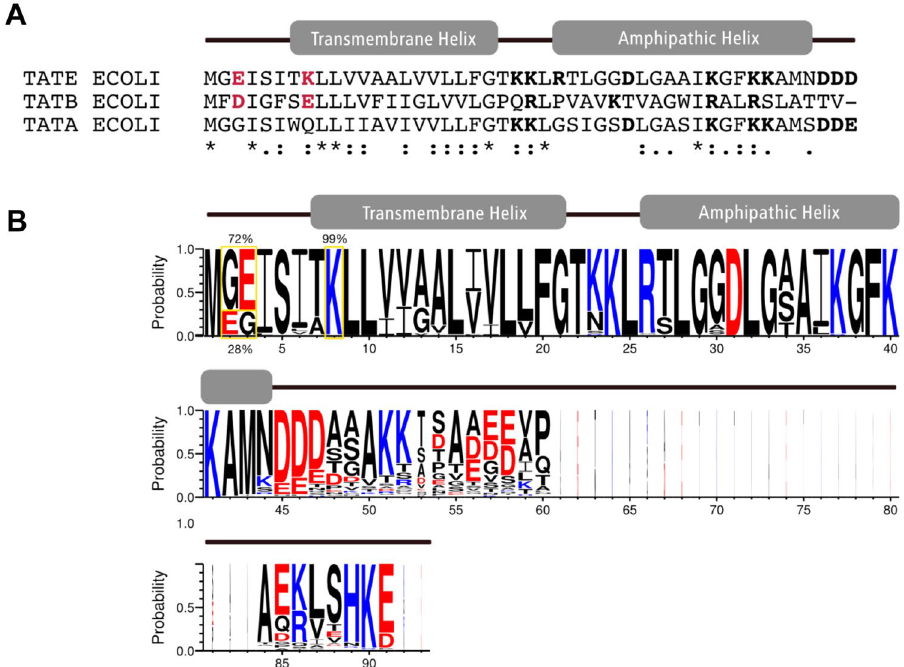
Figure 3. Similar to TatB, TatE has conserved N-terminal charges. ( A ) Sequence alignment of the amino acid sequences of E. coli TatE (accession number: P0A843), TatB (P69425) and TatA (P69428). N-terminal, charged amino acid residues of TatE and TatB are highlighted in red, other charged residues are in bold. Secondary structural elements are assigned according to the NMR structure of TatAd from B. subtilis 9 based on the multiple sequence alignment to its E. coli homologues (see Fig. 5B). ( B ) Consensus sequence of TatE obtained from the alignment of 111 distinct TatE protein sequences encoded by members of the Family of Enterobacterales . The N-terminal charged amino acids are boxed and their degree of conservation is